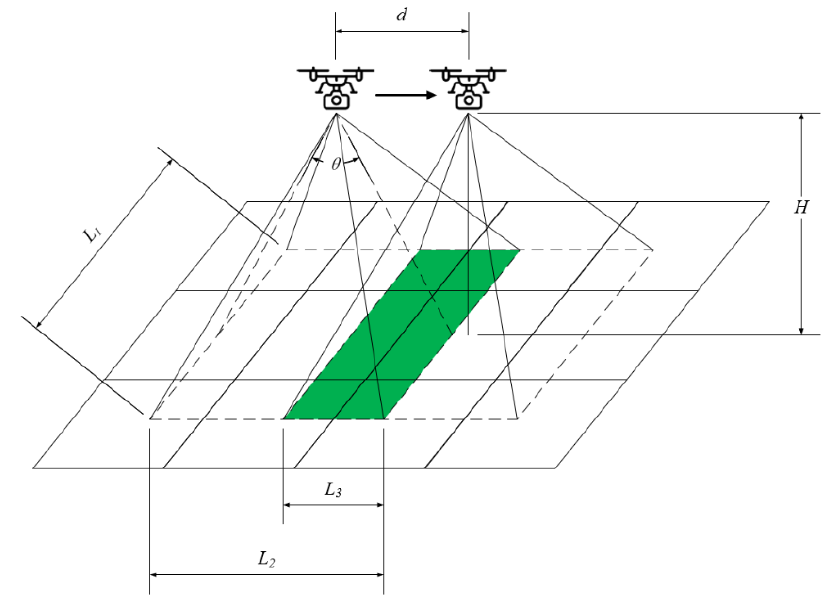
Figure 2. Two adjacent photography sites for a UAV (unmanned aerial vehicle). The camera is perpendicular to the ground to optimize the view of the ground. Since the UAVs fly at a fixed altitude, L 1 and L 2 remain the same during the